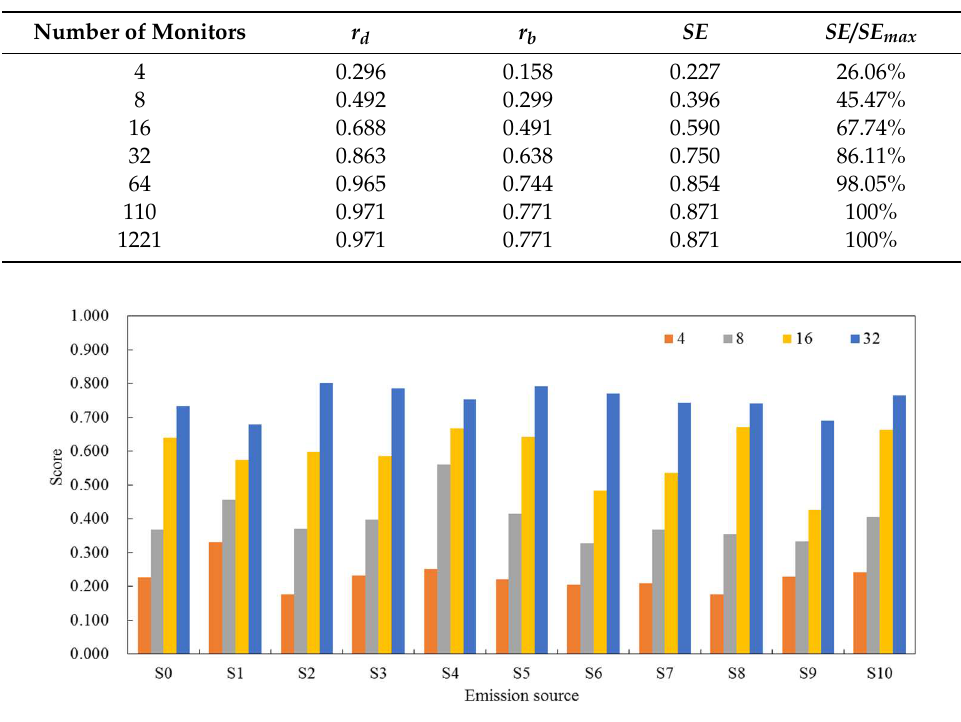
Figure 6. Surveillance Efficiency ( SE ) scores of each emission source under optimal AQMNs with different known numbers.